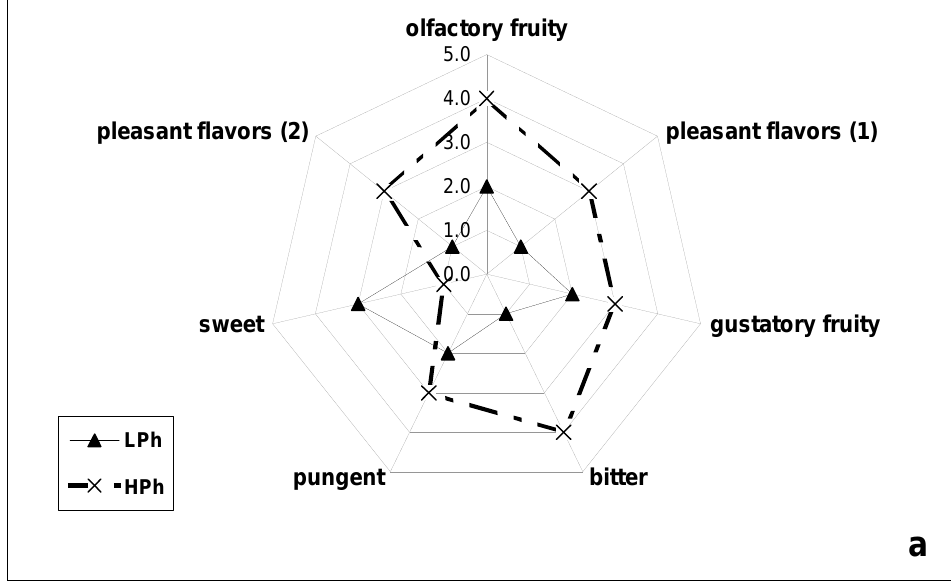
Figure 2 Sensory profile and phenolic content of two different VOO (HPh, high phenols oil and LPh, low phenols oil). a , sensory profiles of samples by Quantitative Descriptive Analysis (QDA); the intensity of each descriptor is evaluated on a 0-5 points scale; different perception routes: (1) orthonasal, (2) retronasal. b , single and total phenolic content of samples; A, hydroxytyrosol; B, tyrosol; C, vanillic acid; D, unknown phenolic compound with a retention time of 30.69 min; E, unknown phenolic compound with a retention time of 36.27 min; F, 3,4-DHPEA-EDA; G, (+)-pinoresinol; H, (+)-1- acetoxypinoresinol + p -HPEA-EDA; I, 3,4-DHPEA-EA; L, p